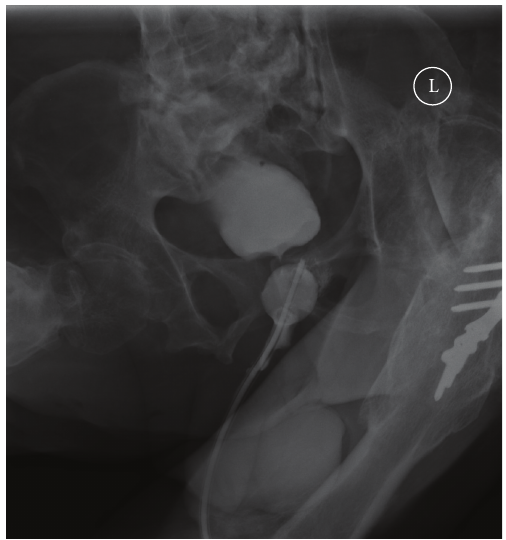
Figure 1: Cystogram showed the tip of catheter to be located outside the bladder in the urethral false passage.